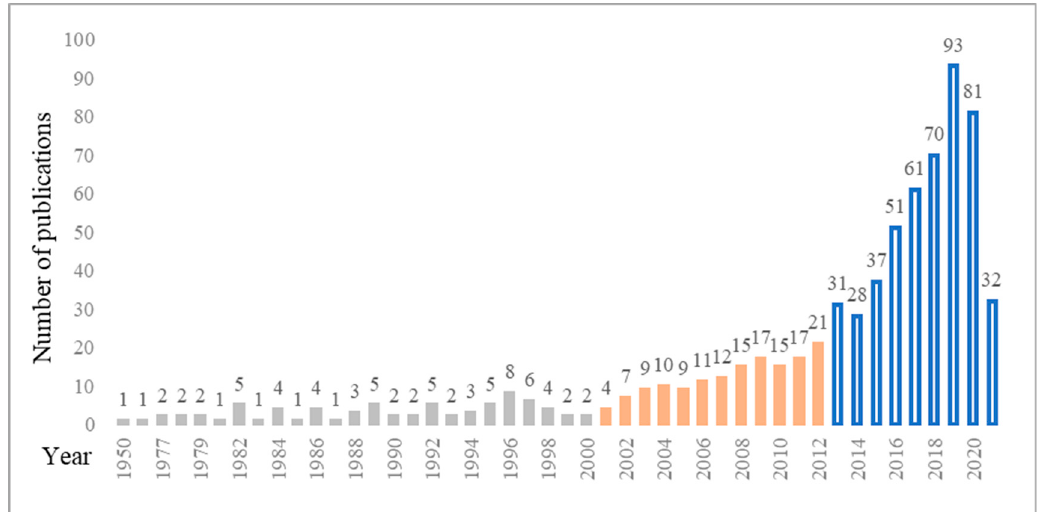
Figure 2. Average number of publications per year on land consolidation and rural revitalization from 1950 to 2021.